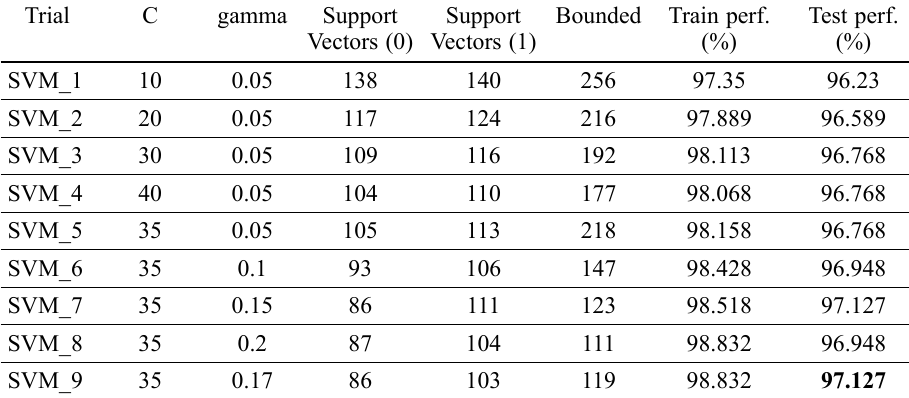
Table 4. Trials for SVM